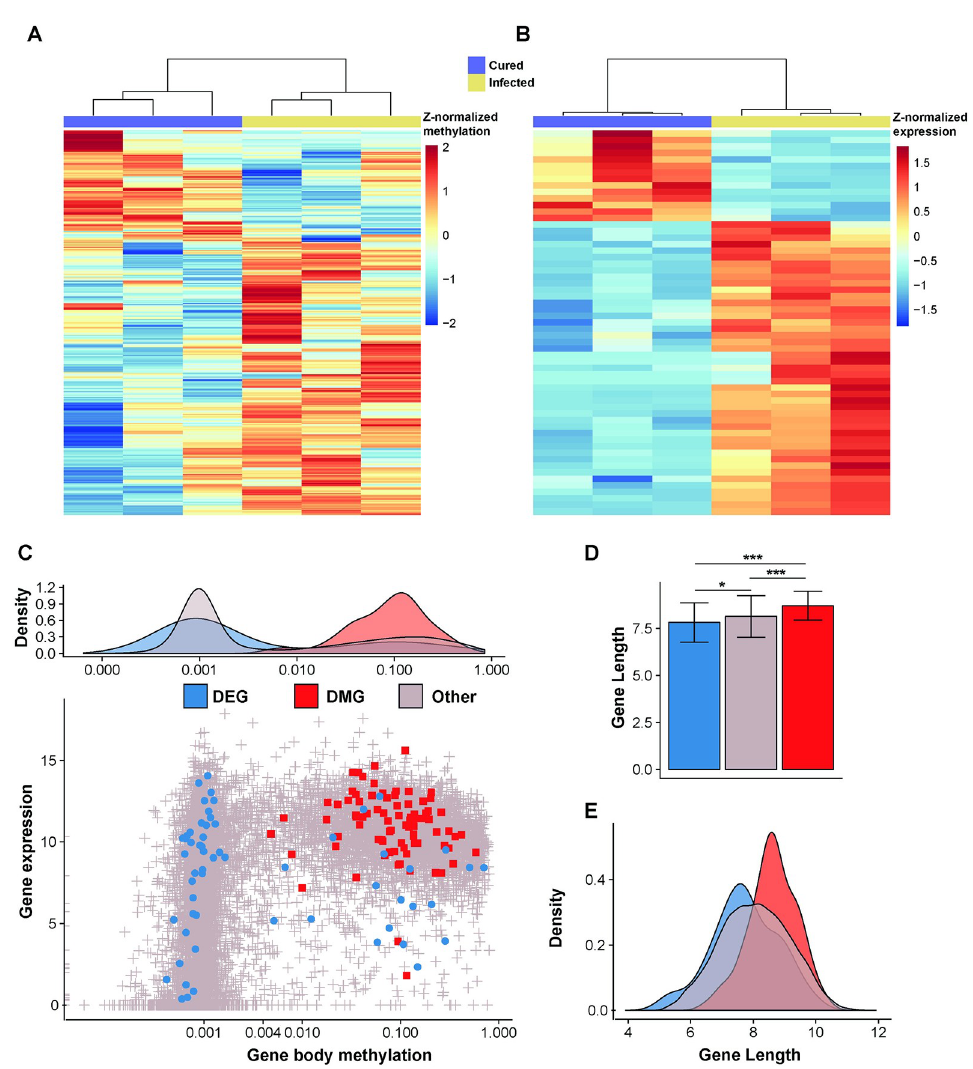
Fig 2. Differential methylation and expression between Wolbachia infected and cured lines. A) Heatmap of 340 significantly differentially methylated positions (DMPs, found within 84 genes) detected using RADMeth. More sites exhibit increased DNA methylation in the infected lines (239 out of 340 DMPs are hypermethylated in the infected lines compared to cured lines). B) Heatmap of 59 differentially expressed genes, the majority (39 out of 59; χ 2 , P = 3.13x10 -6 ) of which were up-regulated in the infected lines. C) Gene body fractional methylation and gene expression relationship between DEG, DMG and other genes (genes that are neither DEG or DMG) accompanied by gene body fractional methylation densities of each gene class. Gene body fractional methylation is calculated as the mean fractional methylation of all CpGs within each gene, and shows a bimodal distribution as in other species [46]. Gene body fractional methylation and gene expression are log 10 and log 2 transformed, respectively, to improve normality. D) Average gene lengths and E) density plot of gene lengths for each gene class. Error bars represent standard deviations.